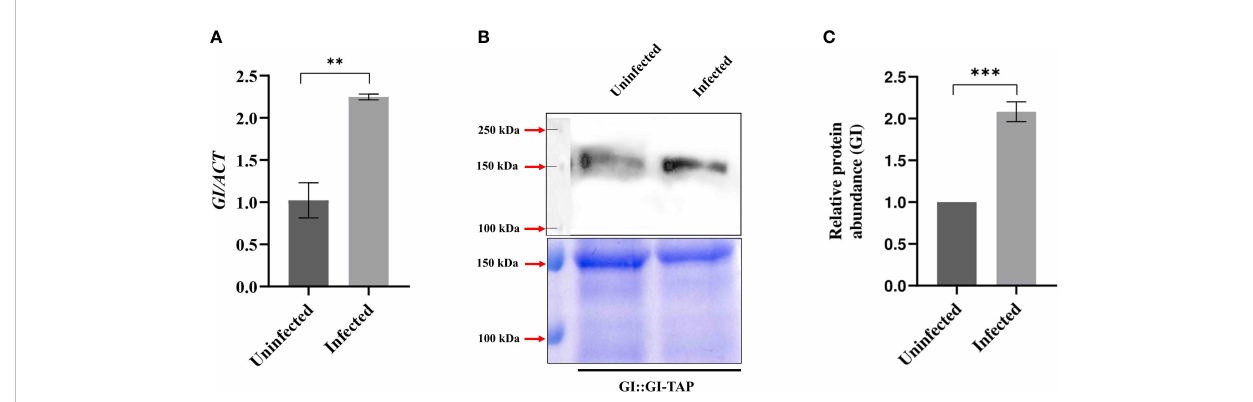
FIGURE 2 Transcript and protein levels of GIGANTEA after F. oxysporum infection . (A) Quantitative RT-PCR results showing GI transcript abundance in uninfected (0 HPI) and 24 HPI in Col-0 leaf samples. Transcript abundance in Col-0 uninfected at 24 HPI was taken as 1 to calculate the relative transcript level of GI . ACTIN was used to normalize transcript levels. (B) Immunoblot detection and (C) relative protein levels of GI in the uninfected and infected GI::GI-TAP leaf samples. (B) Bottom panels show SDS-PAGE stained with Coomassie brilliant blue (CBB). Top panel shows the PVDF membrane blotted against anti-GI monoclonal primary antibody raised in rabbit (unpublished data) and further incubated with secondary antibody anti-rabbit polyclonal HRP for 2 h at room temperature. Detection was done using ECL substrate. The corresponding loading control is shown by CBB-stained gel. (C) For relative protein levels, ImageJ software was used for densitometric quanti fi cation of Western blot and normalization with the loading controls against CBB staining. Calculations were done by taking protein abundance in uninfected conditions at 0 HPI as 100%. The qRT- PCR reactions were done in triplicate from three biological replicates. Data are presented as mean ± SE. To evaluate signi fi cant differences, Student ’ s unpaired t -test was used to compare between uninfected and infected Col-0 plants. ** p < 0.01, *** p <